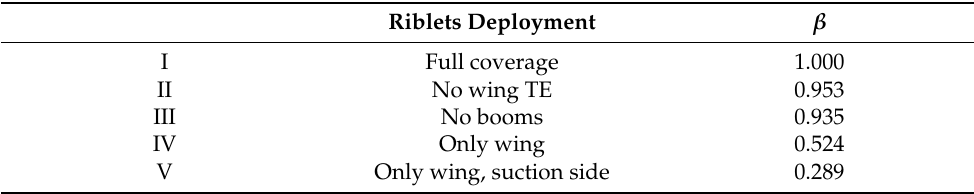
Table 2. Coverage